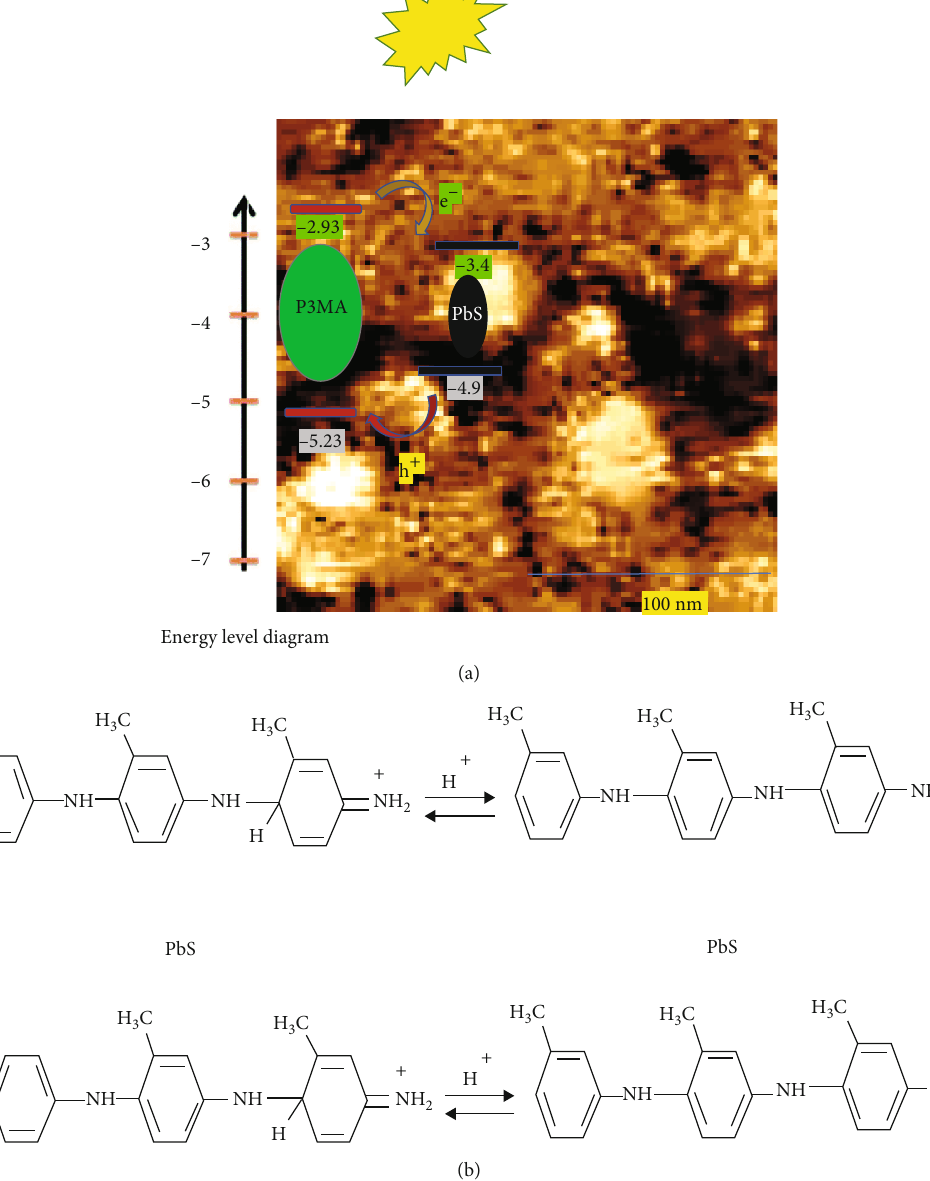
Figure 7: (a) The plausible mechanism of the glass/P3MA/PbS optoelectronic photodetector device and (b) the schematic diagram of the composite